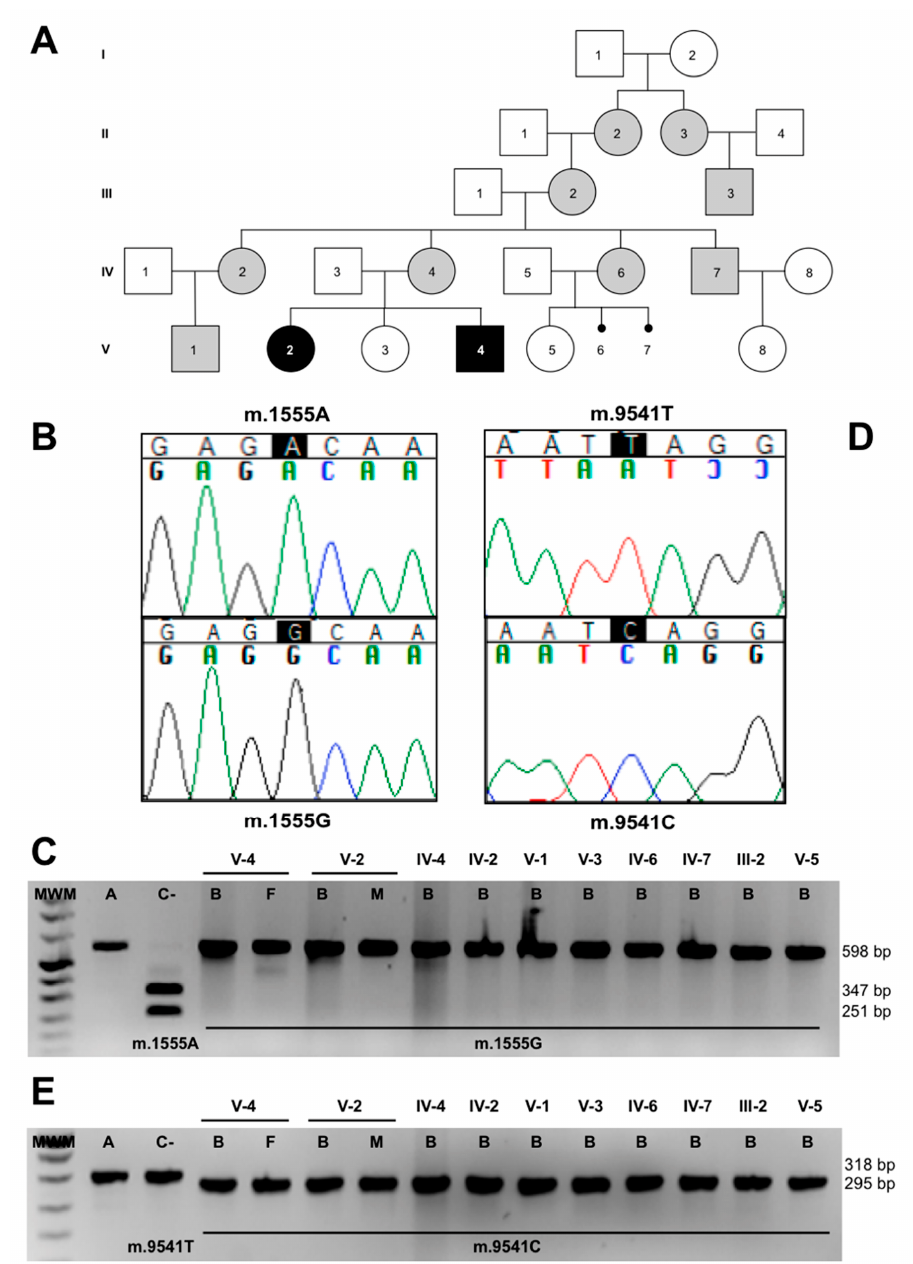
Figure 3. m.1555A > G and m.9541T > C mutations. ( A ) Pedigree. Gray and black colors are code for hearing loss and Leigh syndrome patients, respectively. ( B ) Electropherogram of a segment of the patient’s mtDNA sequence, showing the m.1555A > G transition. ( C ) Restriction fragment length polymorphism (RFLP) gel, showing the mutation load in the pedigree members. ( D ) Electropherogram of a segment of the patient’s mtDNA sequence, showing the m.9541T > C transition. ( E ) RFLP gel, showing the mutation load in the pedigree members. A = amplicon, C- = negative control, B = blood, F = fibroblasts and M = muscle.